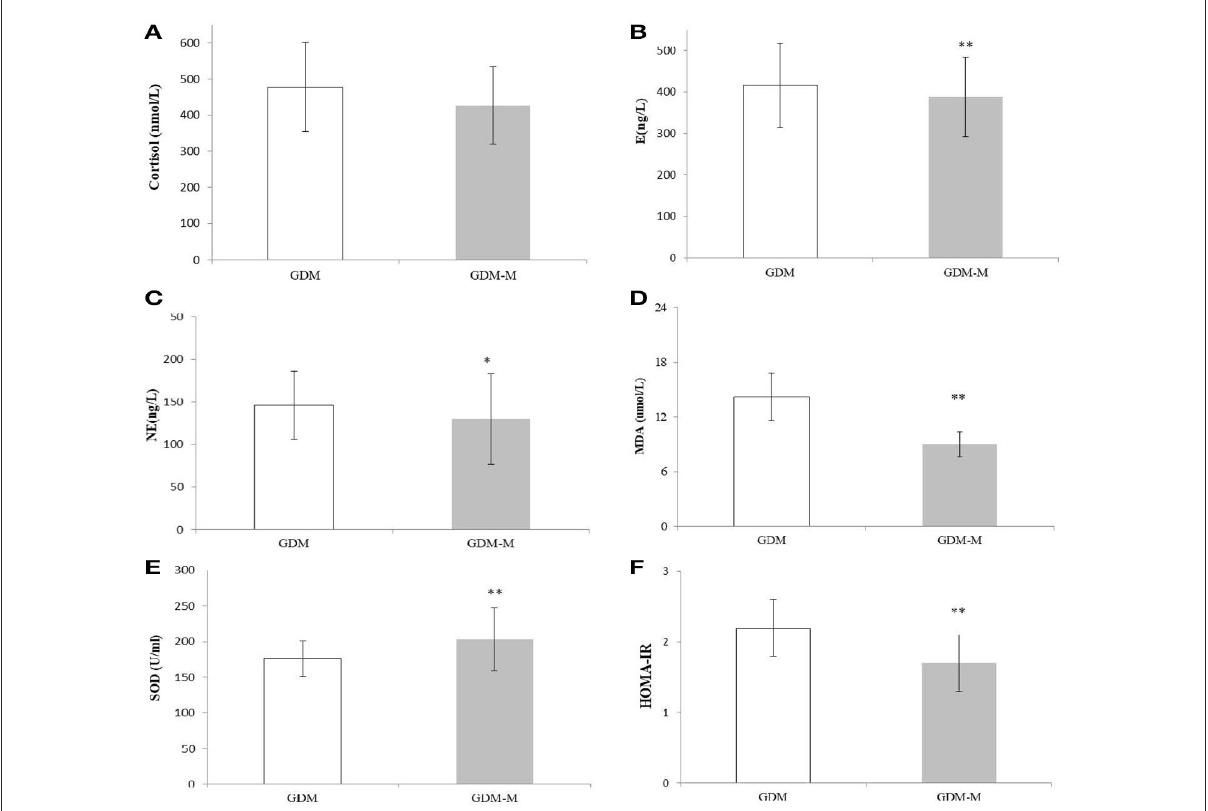
FIGURE1 Histograms of plasma stress, oxidative stress, and glucose-related indexes—cortisol (A) , E (B) , NE (C) , MDA (D) , SOD (E) , and HOMA-IR (F) in two groups. Data are presented as mean ± SD. A two-sample t- test was used to determine whether the differences in the GDM-M group were statistically significant. *Indicates P < 0.05 vs. GDM group, and P < 0.01 is expressed by**. E, epinephrine; NE, noradrenaline; MDA, malondialdehyde; SOD, superoxide dismutase.